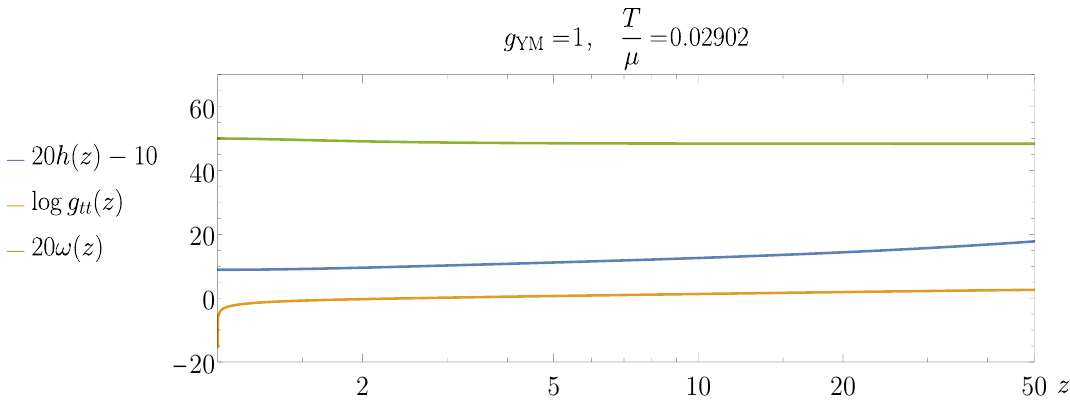
Figure 12. Low temperature plot of the black hole interior functions. The functions plotted h ( z ) , ω ( z ) , log ( g tt ) exhibit tame behaviour in the early interior which is generally the case for lower temperatures.